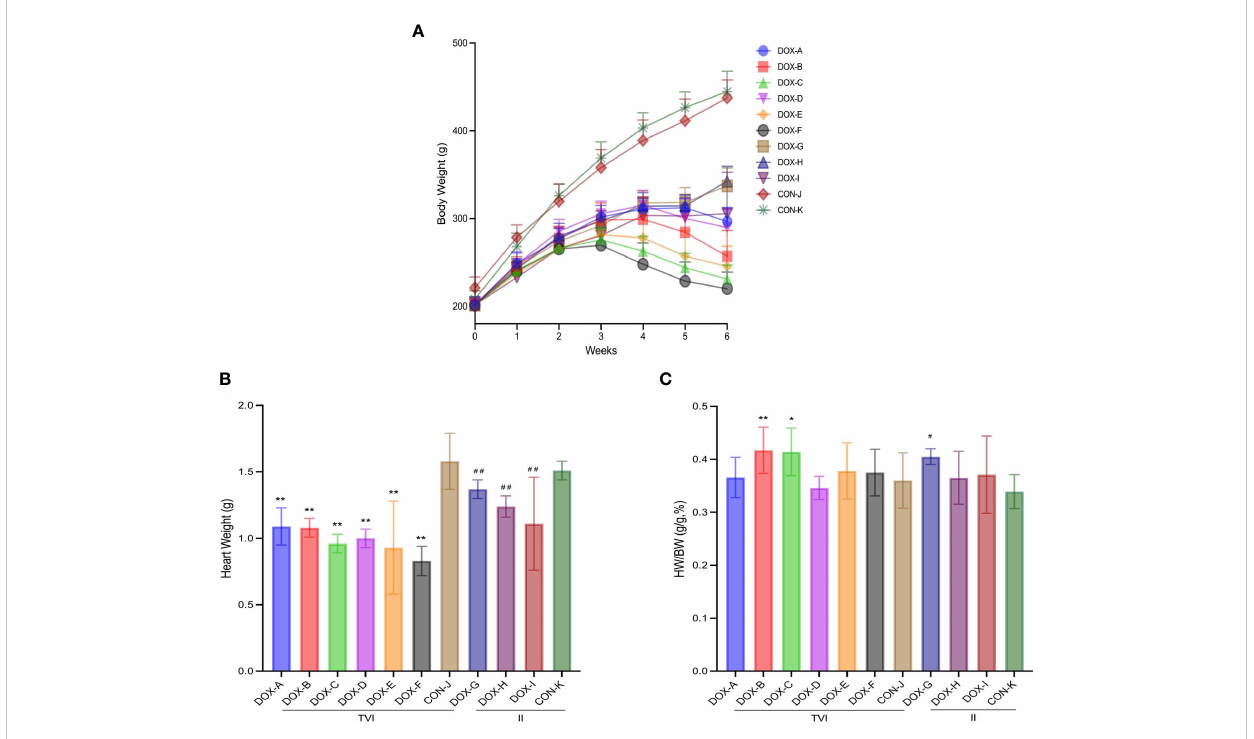
FIGURE 2 Weight results of rats in each group. (A) Change of body weight (BW) during modeling period. (B) Heart weight (HW). (C) BW/HW ratio. CON, control; DOX, doxorubicin; TVI,tail vein injection; II,intraperitoneal injection. Data are presented as means ± SD (n = 7,8 or 9 per group). * P <